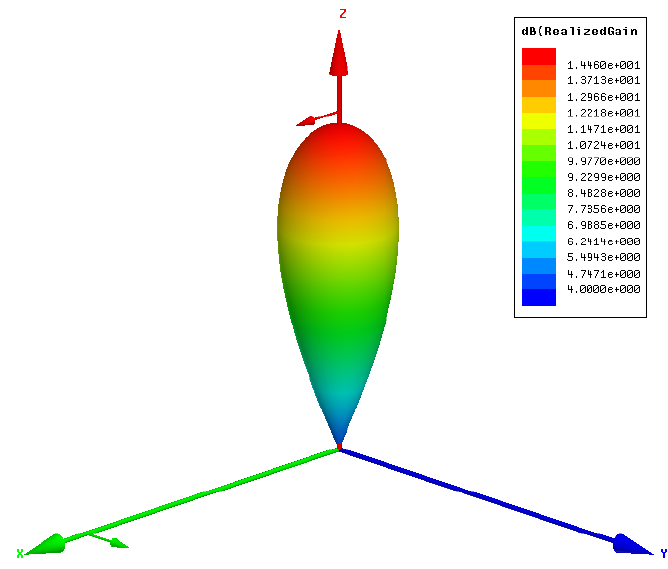
Figure 6. The simulation result of the helical antenna gain pattern.